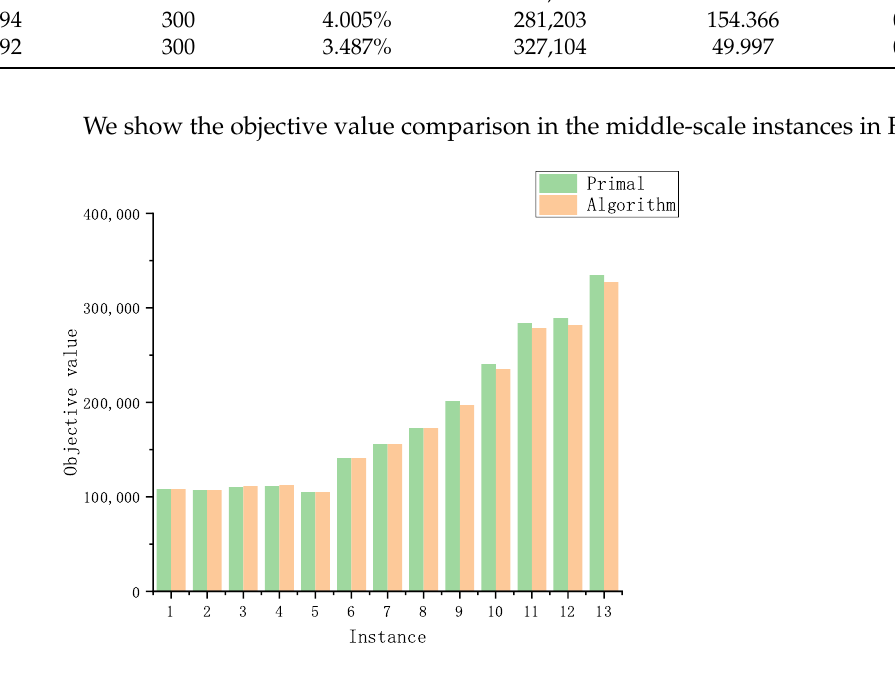
Figure 4. Objective values for middle-scale